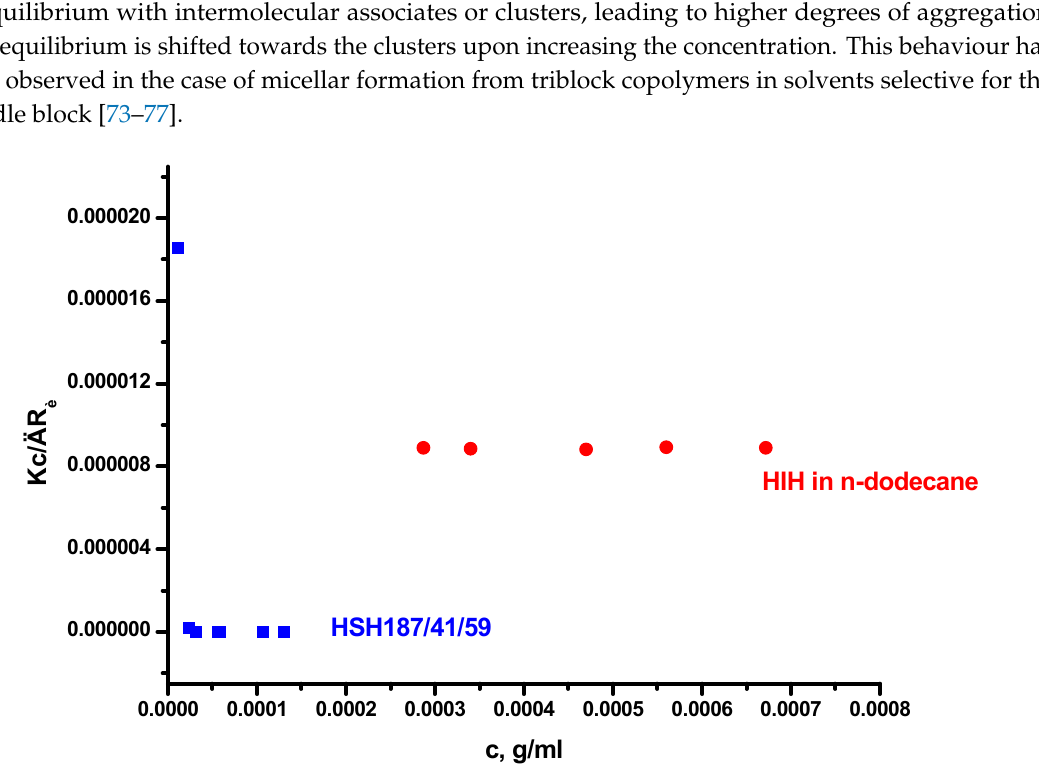
Table 4. Viscometry results of the HSH triblock copolymers in n-heptane.